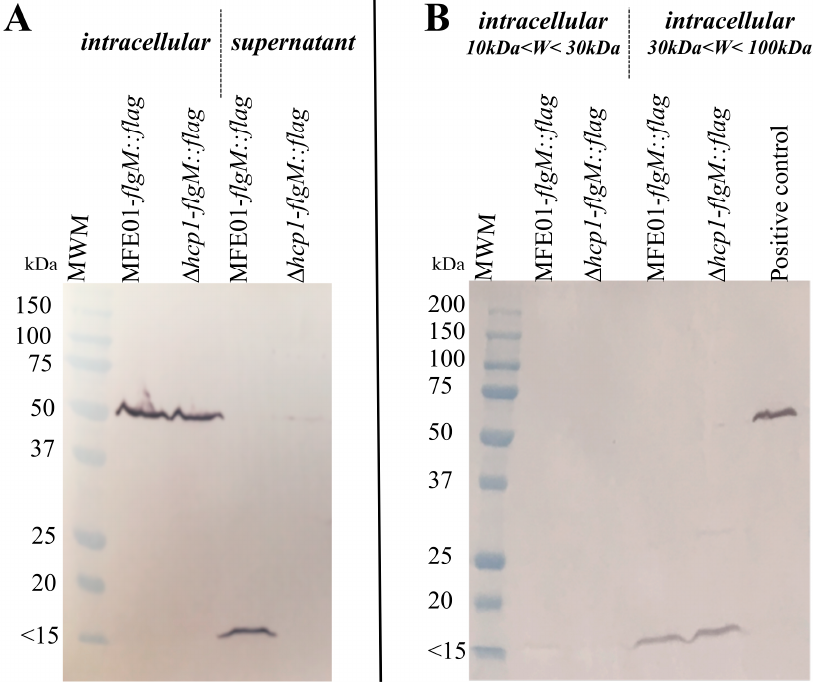
Figure 7. Localisation of FlgM::Flag in MFE01 or MFE01 ∆ hcp1 . ( A ) Western-blot analysis of protein fractions of MFE01- flgM::flag and MFE01 ∆ hcp1 - flgM::flag . An anti-Flag antibody coupled to alkaline phosphatase was used to visualise FlgM-Flag proteins. The images shown are representative of three